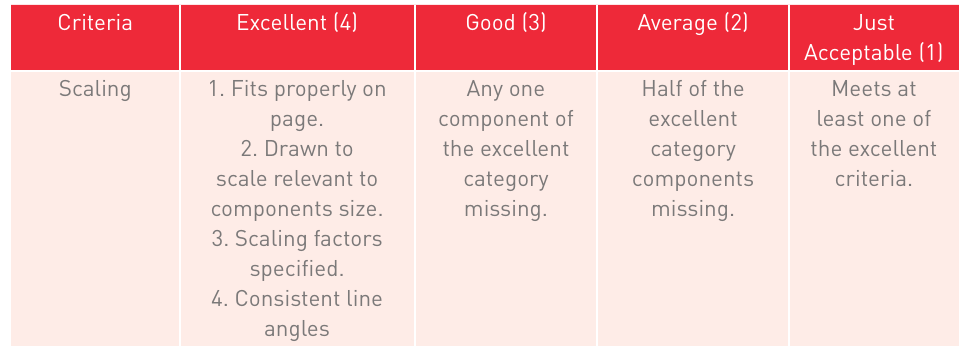
Sketch Assessment Matrix